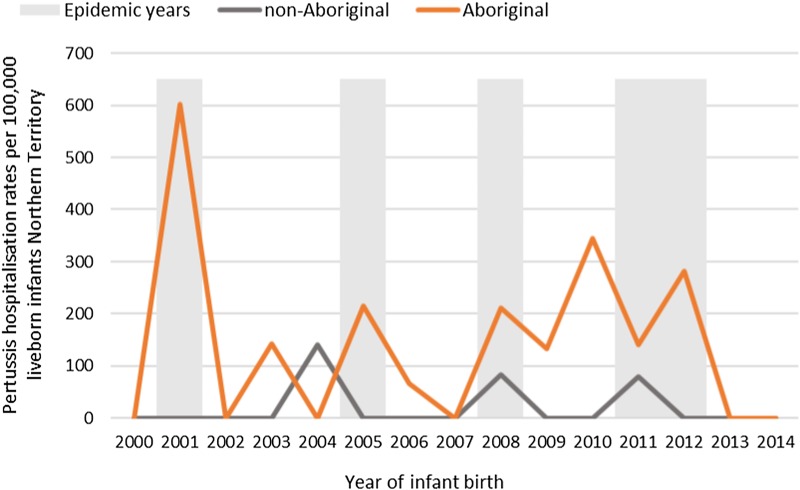
Pertussis hospitalisation rates per 100 000 live births in 0–<7 month old infants, by age in weeks of infant at time of hospitalisation, Northern Territory, Australia (2000–2014).